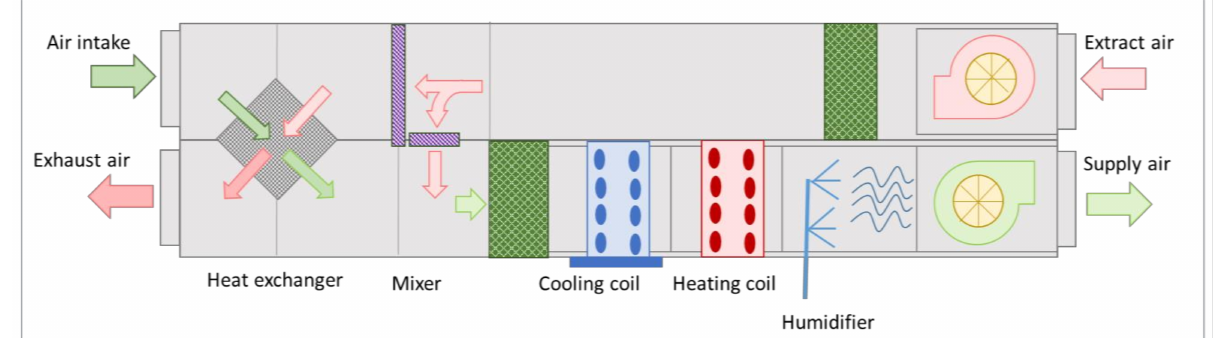
Figure 5. Scheme of a typical AHU and its components.